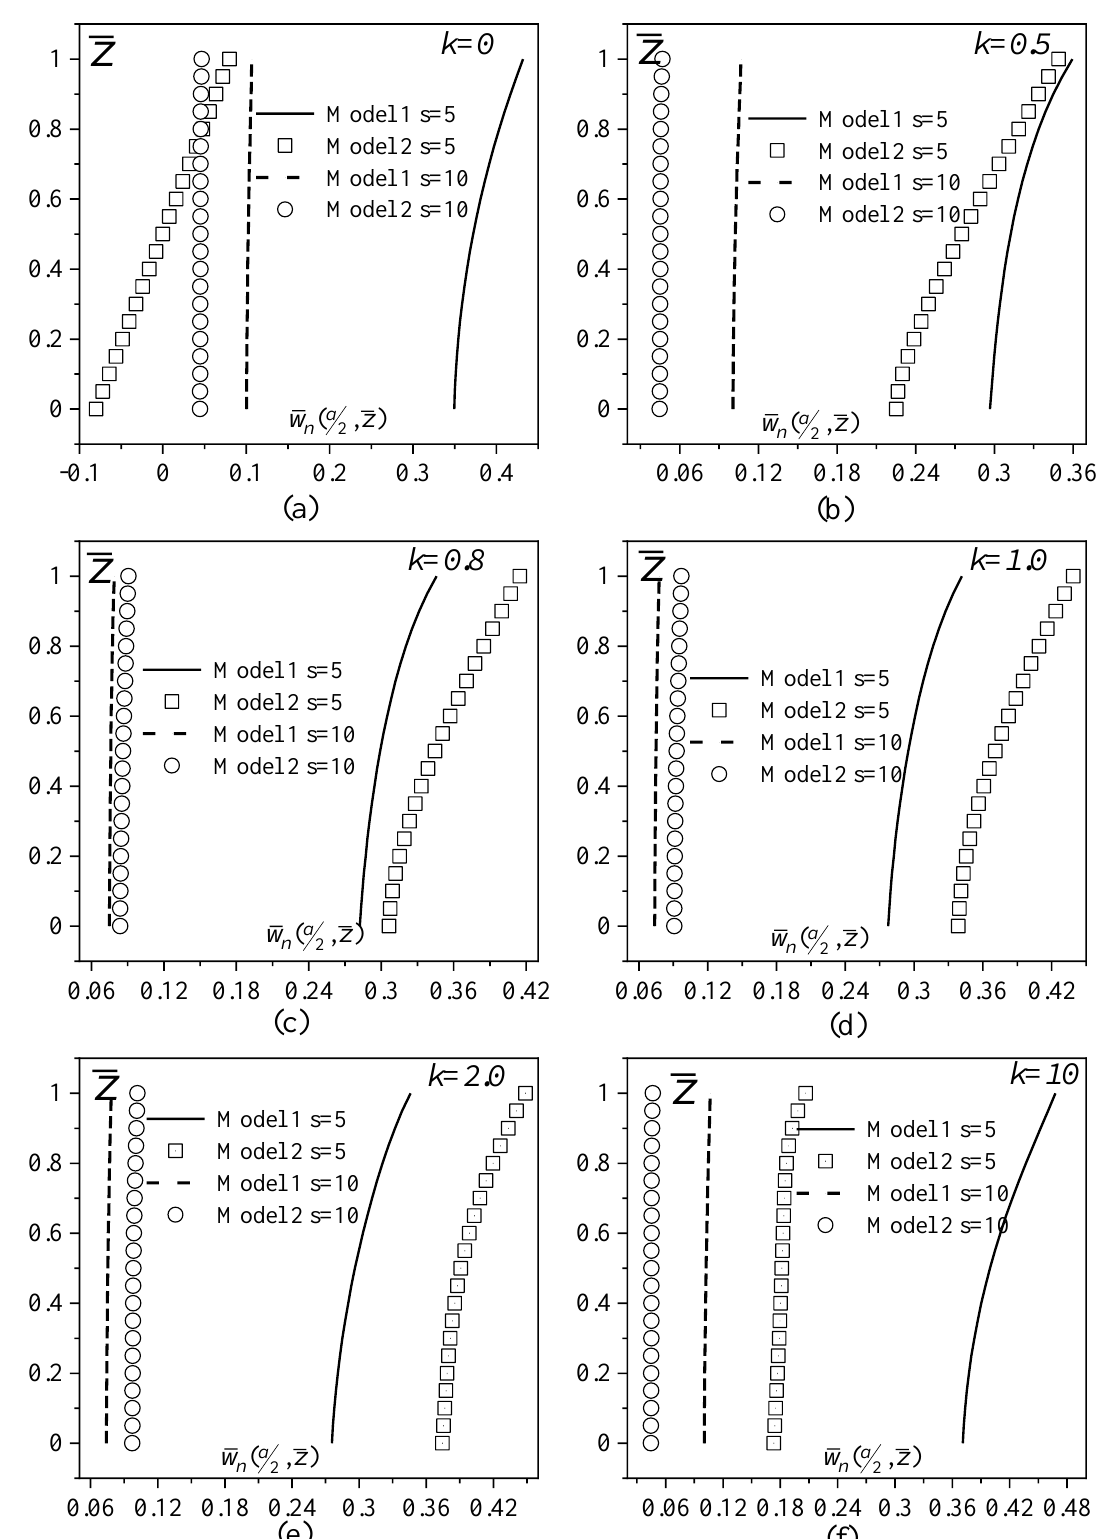
Fig. 6. Thickness variation of normalized transverse displacement (